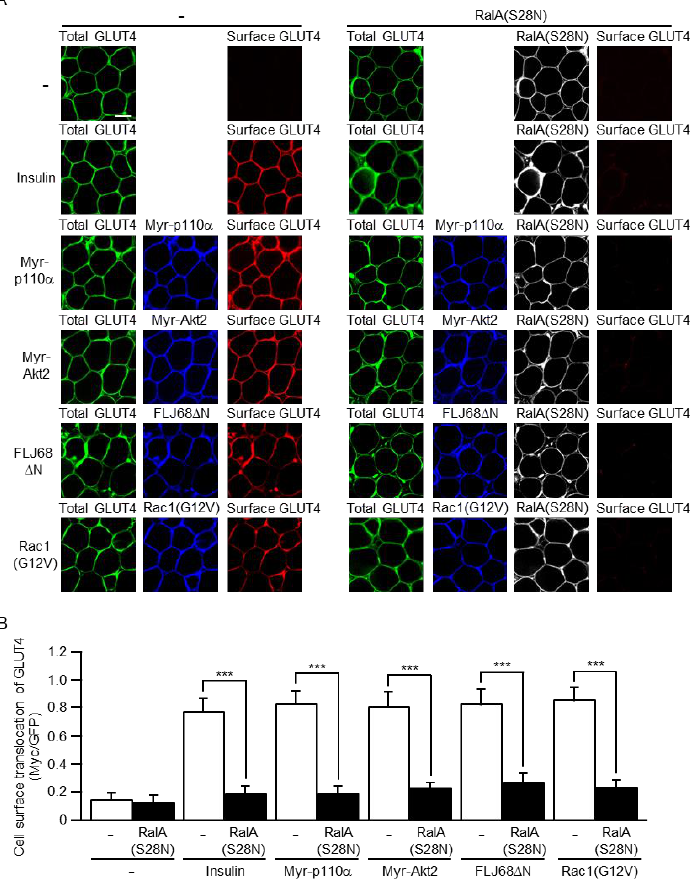
Figure 6. Inhibition of cell surface translocation of GLUT4 induced by insulin or a constitutively activated mutant of PI3K, Akt2, FLJ00068, or Rac1 by a dominant-negative mutant of RalA. ( A ) The total amount of GLUT4 myc 7-GFP was estimated by the fluorescent intensity of GFP. Myr-p110α, Myr-Akt2, FLJ68ΔN, and Rac1(G12V) were visualized by immunofluorescent microscopy using an anti-HA antibody. Cell surface-localized GLUT4 myc 7-GFP was visualized by immunofluorescent microscopy using an anti-Myc antibody. Scale bar, 50 µ m. ( B ) Cell surface translocation of GLUT4 myc 7-GFP shown in ( A ) was quantified. Data are shown as means ± S.E. ( n = 15). *** p <